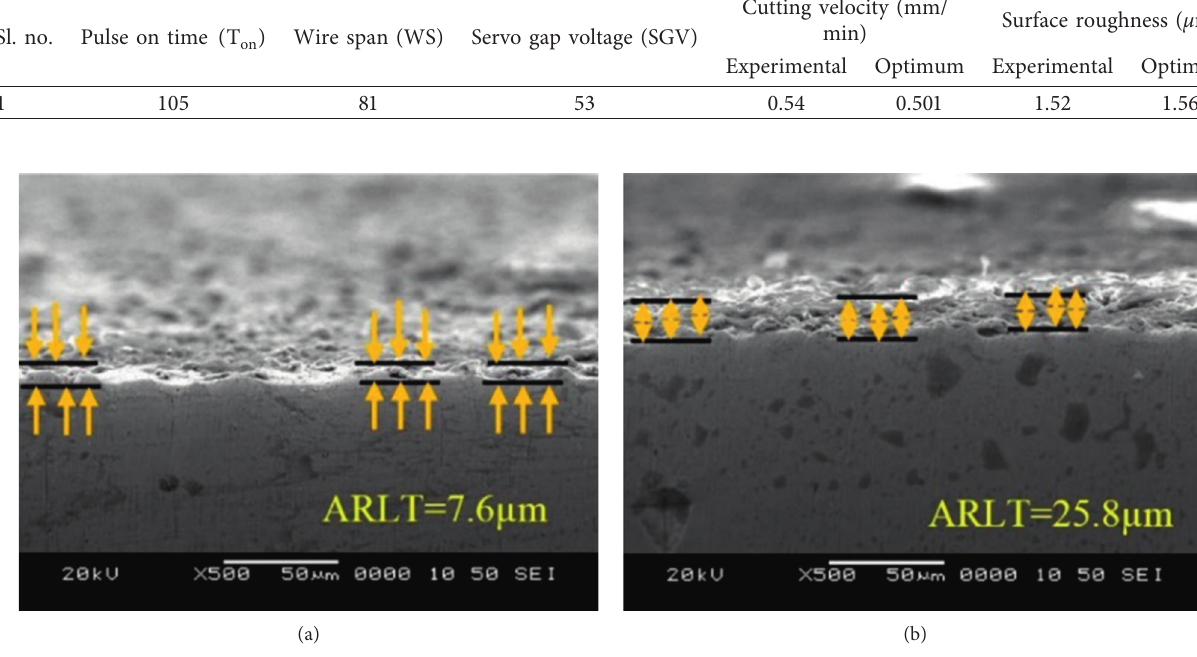
Figure 4: SEM images of WEDMed surface. (a) Lowest machining parameter. (b) Highest machining parameter.